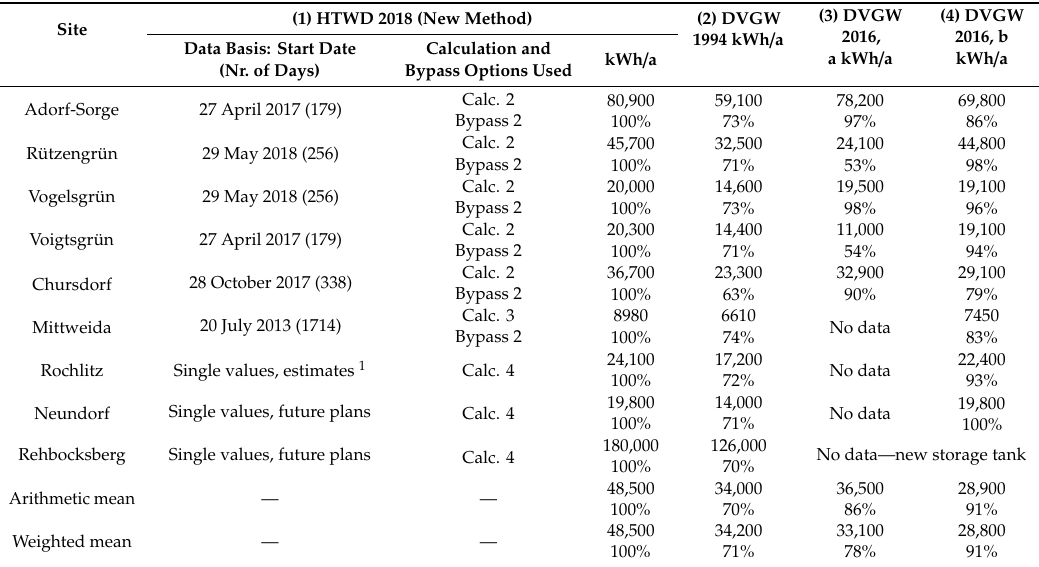
Table 6. Comparison of the estimated E electrical (in kWh / a) achieved by four di ff erent turbine design methods, in italics as percentages of the value given by method